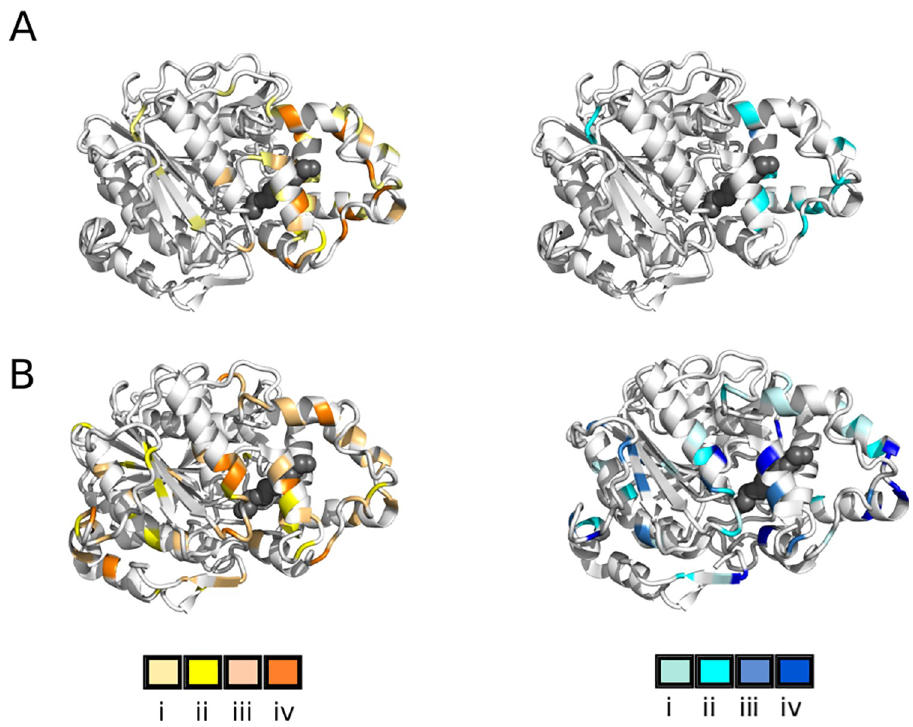
Fig 3. Activity level of the discriminative variants towards short and long chain triglycerides. A: Variants selected from library Random 2. B: Variants selected from libraries Random Tot and Random Rec, combined. Left panels, short-chain activity (hydrolysis of tributyrin): gradient from light yellow (low activity) to orange (high activity). Right panels, long-chain activity (hydrolysis of olive oil): gradient from light (low activity) to dark blue (high activity). Inactive variants coloured as background (gray). Wild-type activity corresponds to shade iii. Where more than one discriminative variant was mutated at the same position, the position is colored according to the variant having the highest activity. A PEG-4 molecule is shown in black spheres, crystallized inside the putative tunnel [22, 29]. Libraries Random Tot and Random Rec are individually represented in S1 Fig. Libraries Random 1 and Random 3 did not yield discriminative variants and are not